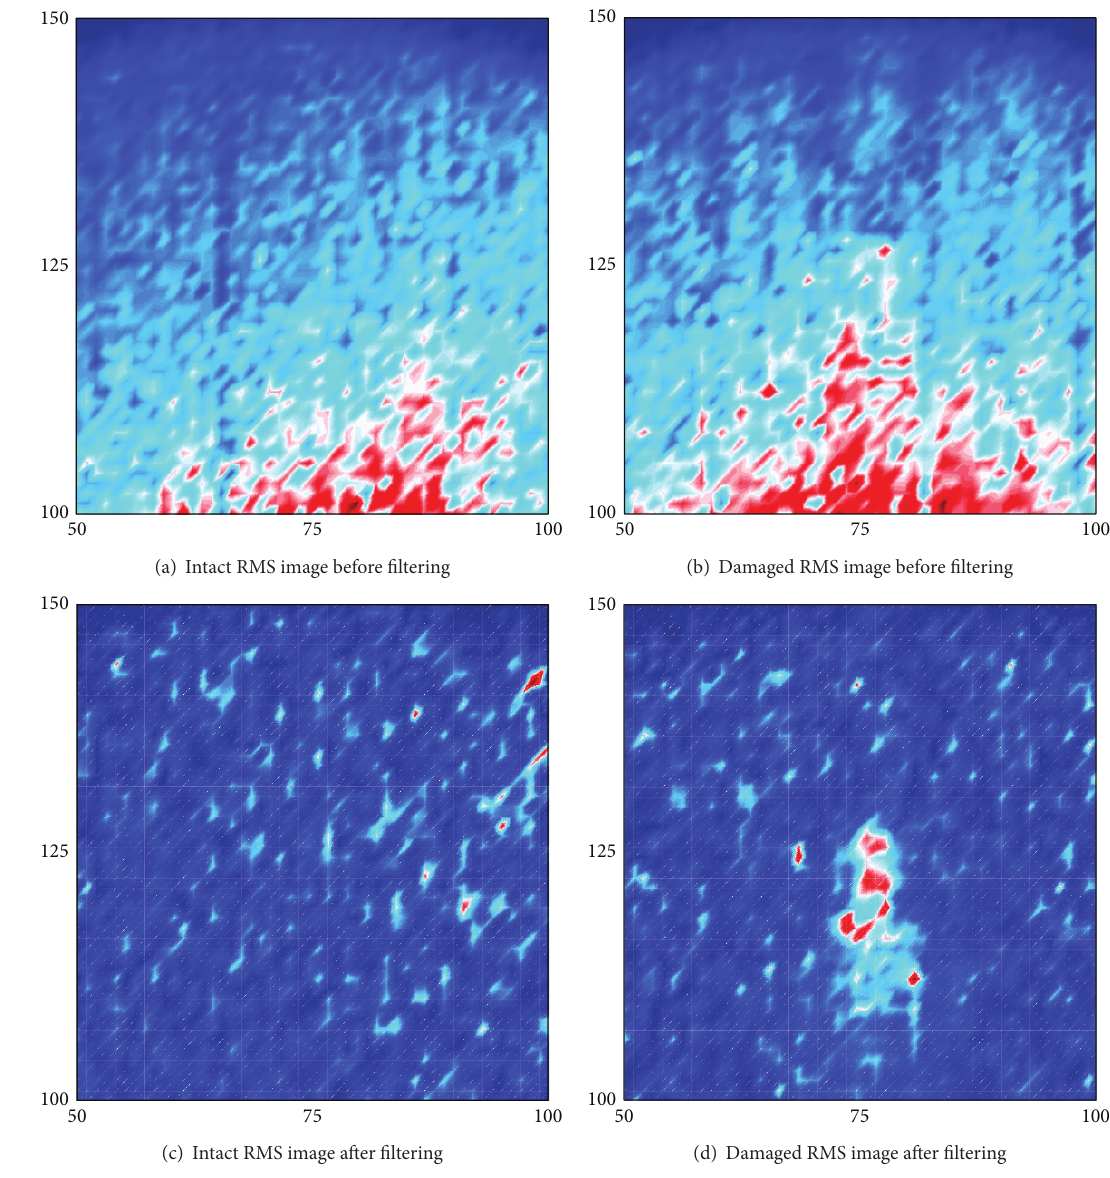
Figure 12: Comparison of RMS snapshots at 48 𝜇 s for damage case